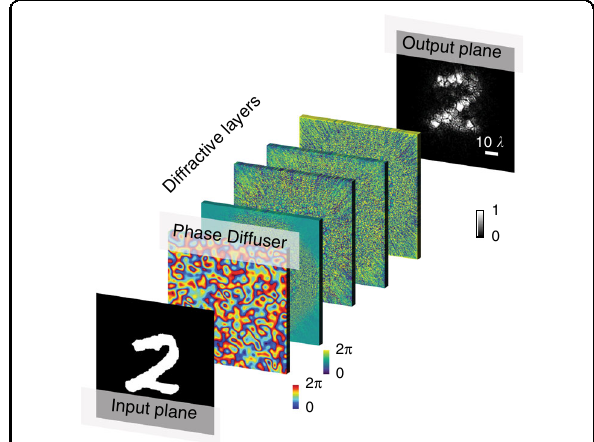
Fig. 1 Diffractive deep neural network for computer-free computational imaging through random diffusers. Speed-of-light inference of the letter “ 2 ” through the unknown “ phase diffuser ” using the trained D 2 NN, which consists of multiple diffractive